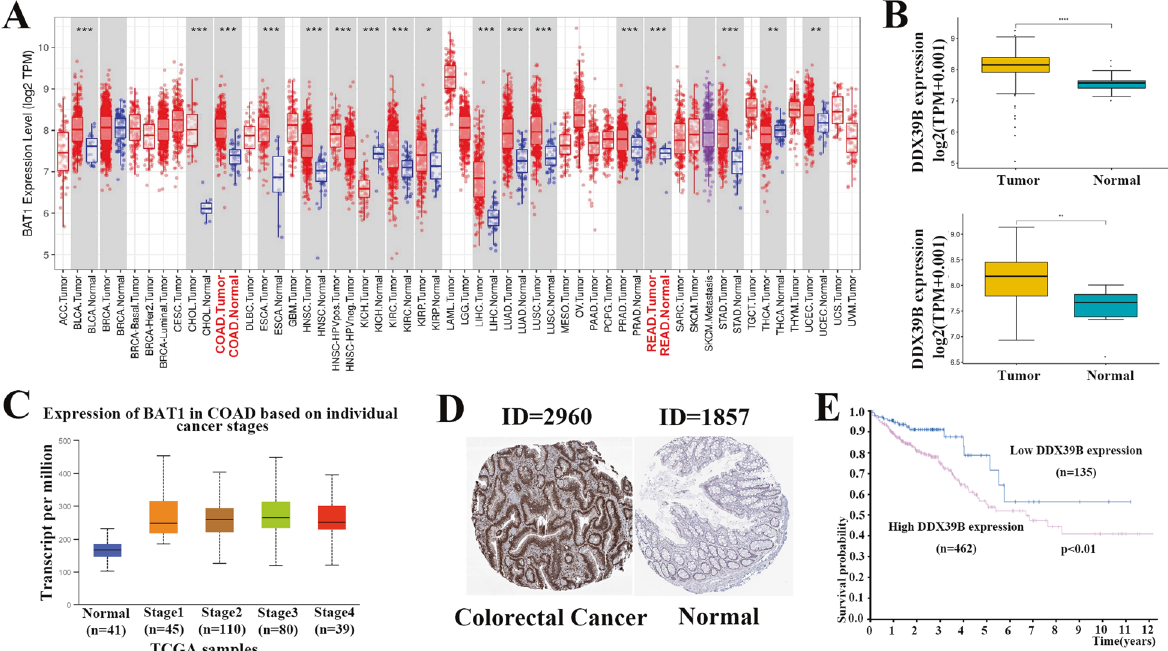
Fig. 1 The expression levels of DDX39B in colorectal cancer tissues and its relationship with prognosis. A mRNA expression levels of DDX39B were explored in different cancer types via TIMER. B The expression of DDX39B is increased in the colon adenocarcinoma (COAD) and rectal adenocarcinoma (READ) compared to the normal tissues. C Expression levels of COAD were explored based on individual cancer stages. D Immunohistochemistry staining of DDX39B in colorectal cancer and normal tissues were explored in the HPA (Human Protein Atlas) database. E Kaplan – Meier curve of OS of COAD were explored based on the expression of DDX39B. Patients were separated either Low (blue, n = 135) or High (red, n = 462) expression of DDX39B in the HPA database. P value was calculated in the